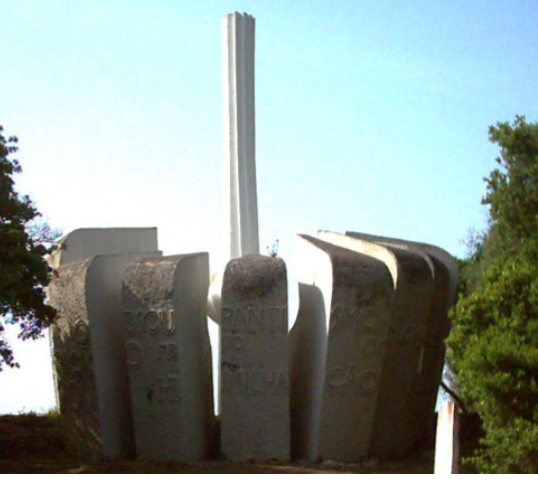
FIGURE 17 | J. Aurélio, Monument to the Fearless General, 1976, landscape site, Cela Velha.